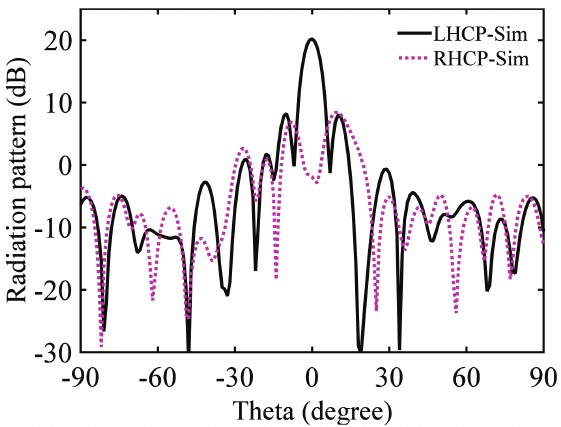
Figure 9: Simulated radiation patterns of the proposed HPM reflectarray antenna along the ϕ = 0 cut.